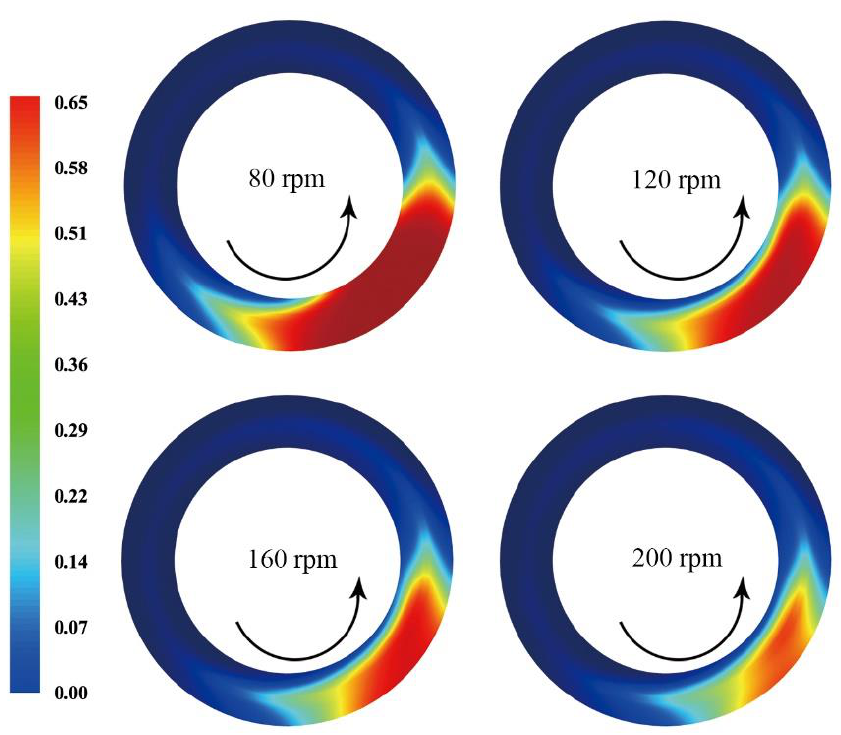
Figure 7. Annular cuttings concentration contour at different rotational speed conditions.